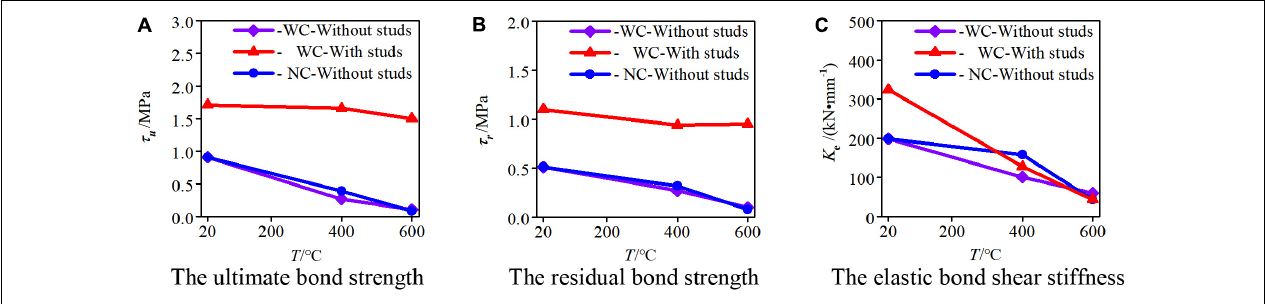
FIGURE 6 | Effect of temperature. (A) The ultimate bond strength. (B) The residual bond strength. (C) The elastic bond shear stiffness.